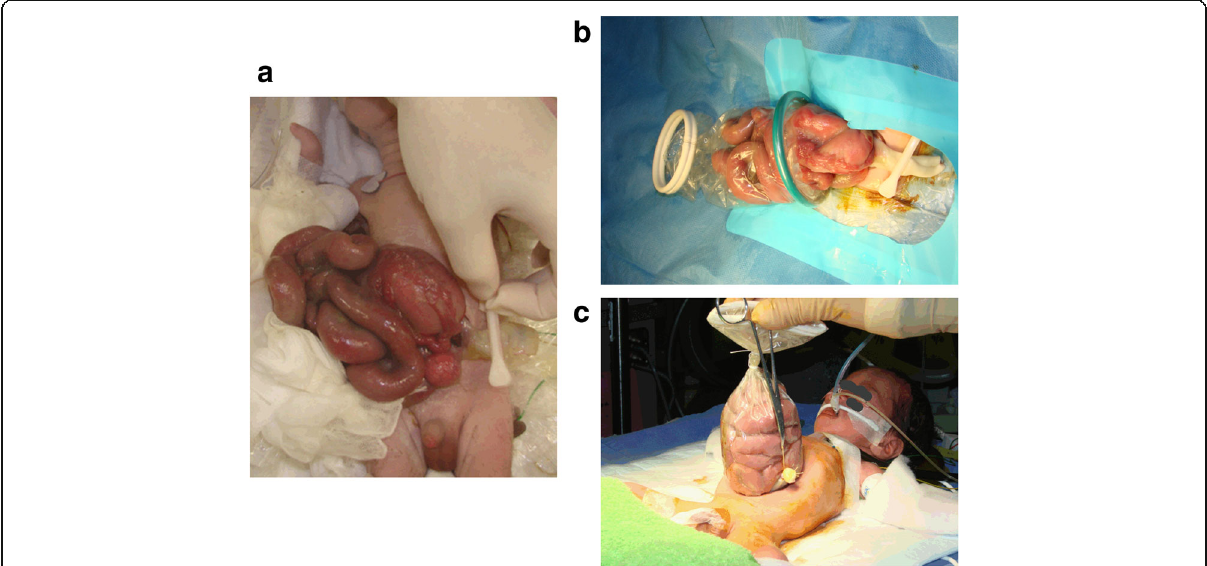
Fig. 1 Gastroschisis at delivery. a The bowel showing marked edema was protruding through the abdominal wall defect. b The wound retraction system